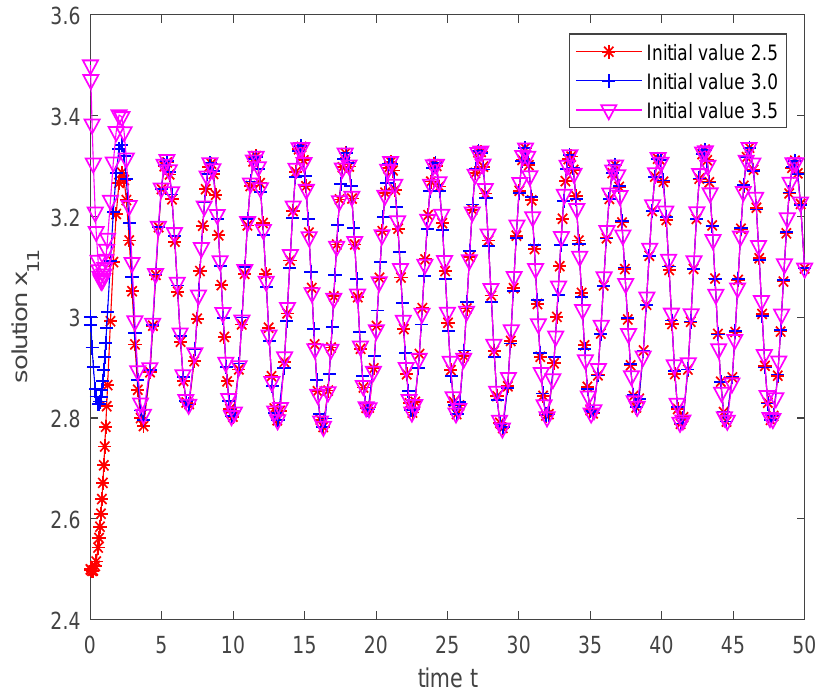
Figure 1. The state trajectory of x 11 , and initial values are 2.5,3.0,3.5, respectively.